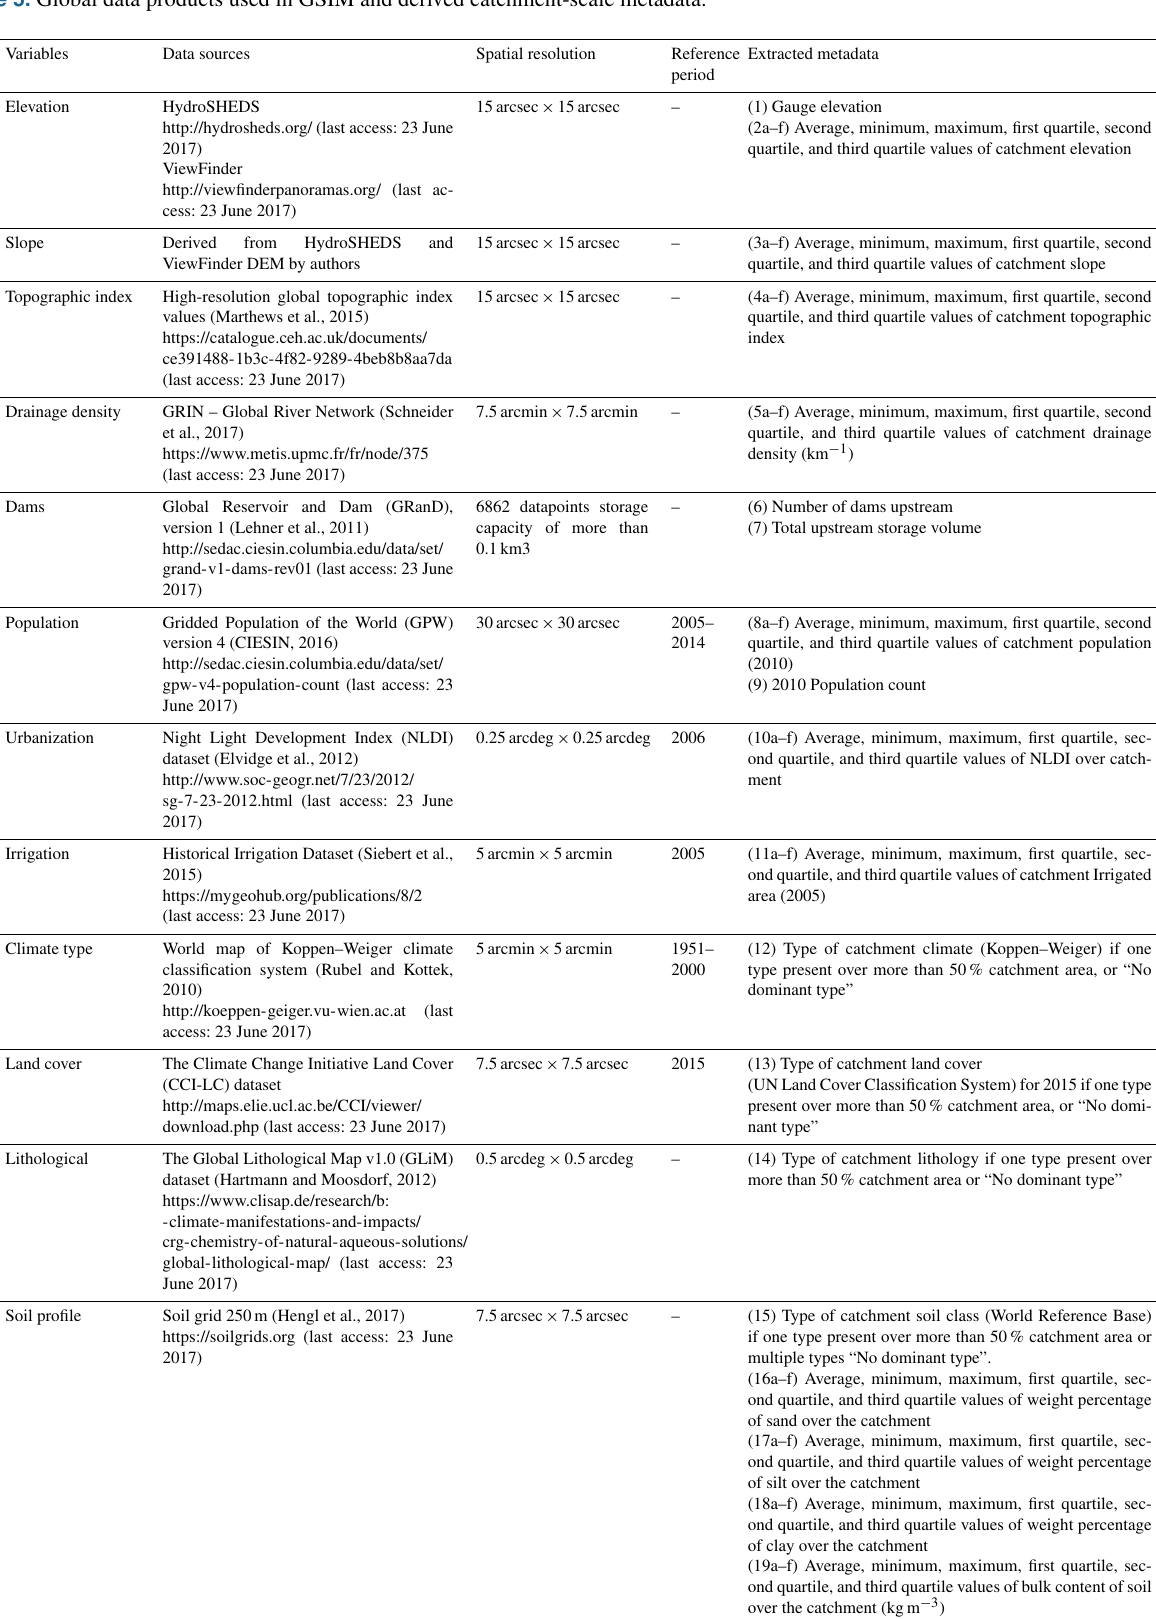
Table 5. Global data products used in GSIM and derived catchment-scale